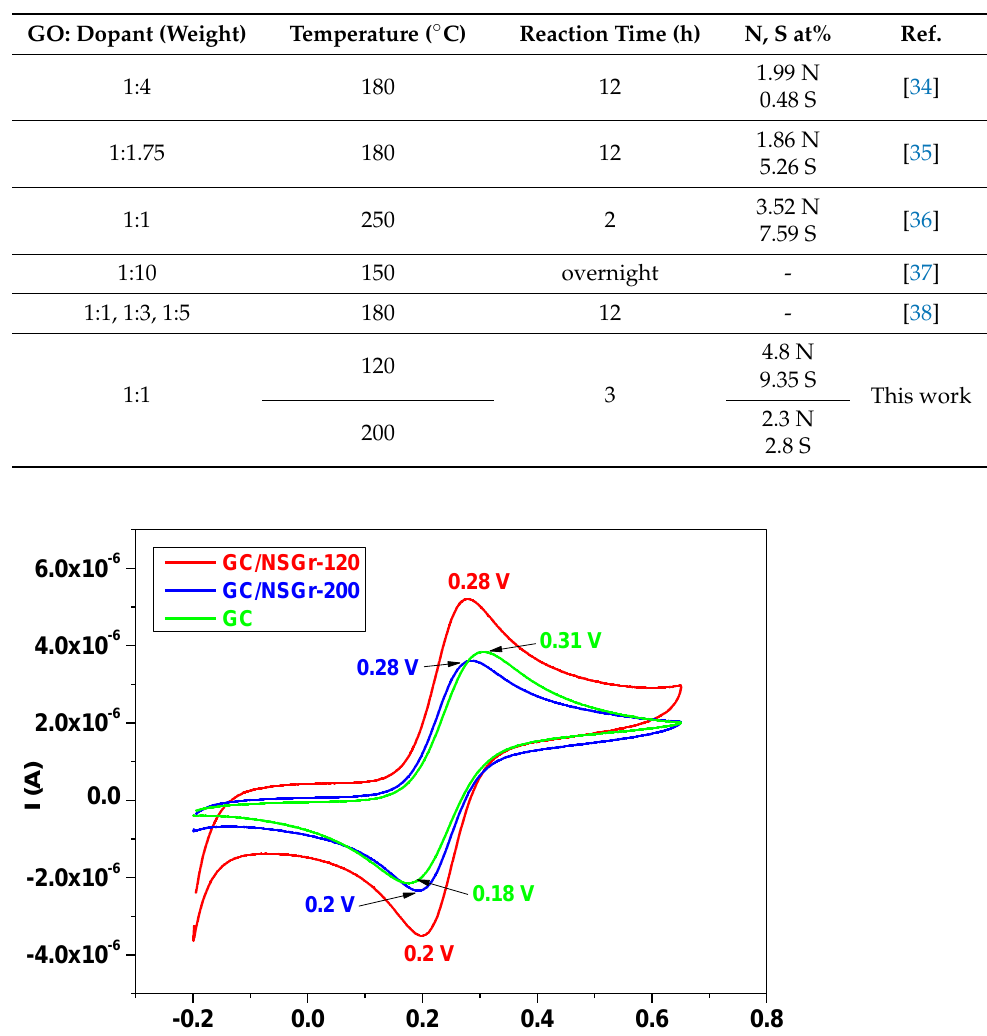
Table 4. Comparison with other graphene samples obtained by hydrothermal synthesis.